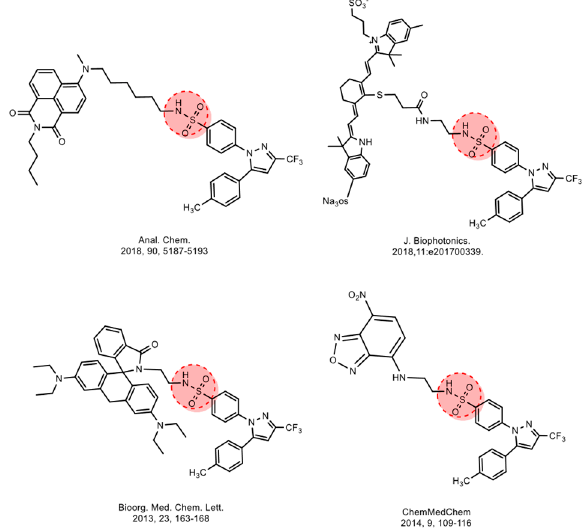
Figure 1. The traditional celecoxib guided cyclooxygenase-2 (COX-2) probes.